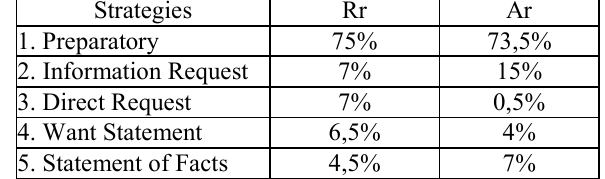
Table 1 – Request head act strategies used by the Russian respondents (Rr) and the American respondents